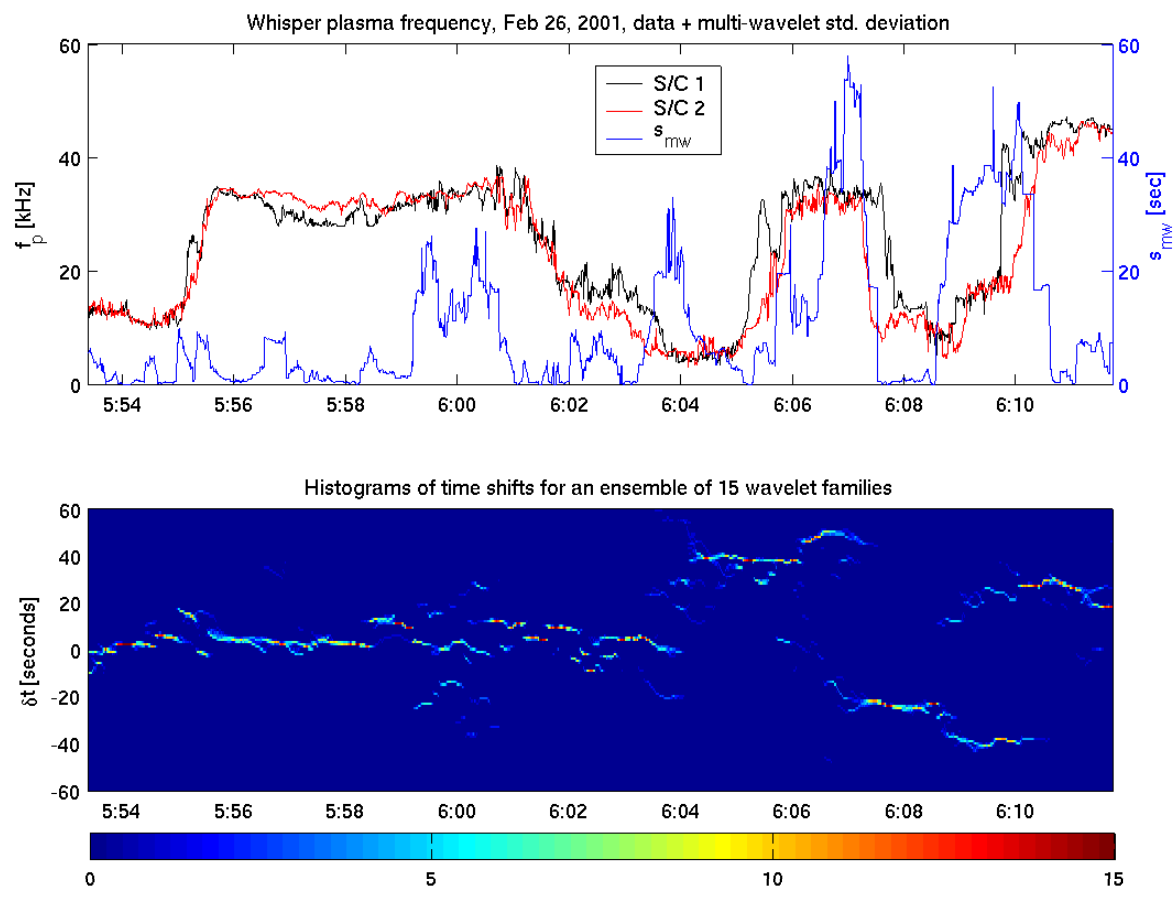
Fig. 3. The multi-wavelet criterion as applied to the density data of Fig. 1. The upper panel displays the density measurements, together with the standard deviation s mw. The bottom panel displays the histogram of the time shifts estimated using an ensemble of 15 different mother